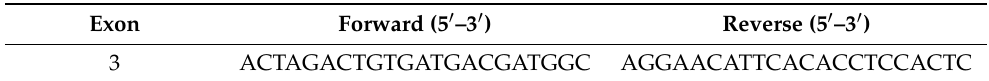
Table 2. Sequence of the primers used for genomic DNA amplification and sequencing of exon 3 of the feline TIM-3